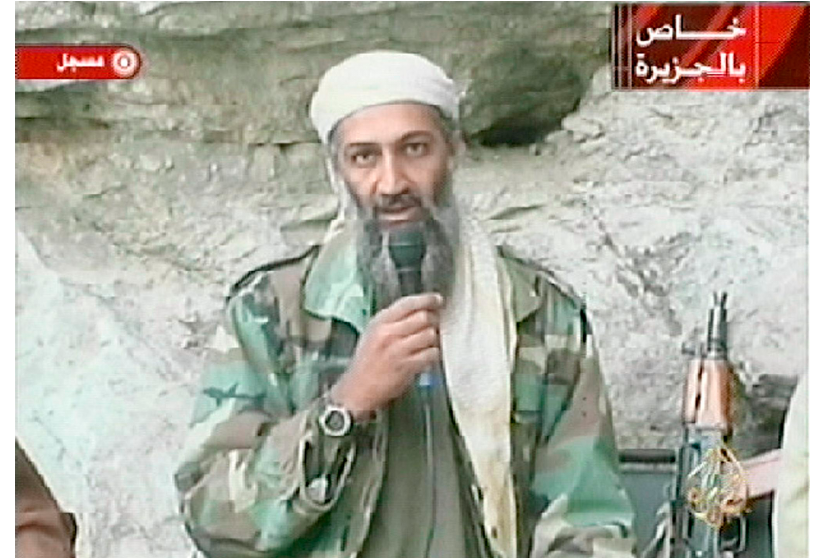
Figure 5. Frame from the video transmitted by Al Jazeera in which Osama bin Laden initially claims generic and partial responsibility for the 11 September attacks on the World Trade Center in New York (Available at: https://www.youtube.com/watch?v=9C5DeMdRcXI, last accessed: 21 August